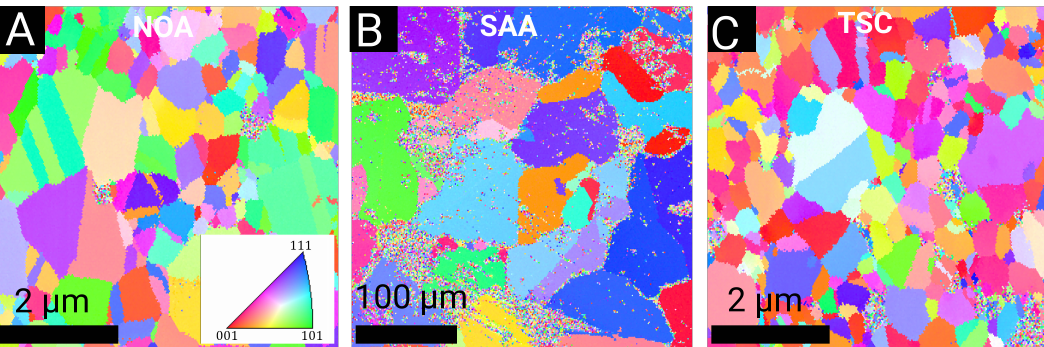
Figure 4. TEM images taken on samples NOA ( A ), SAA ( B ), and TSC ( C ) after heat treatment at 750 K.